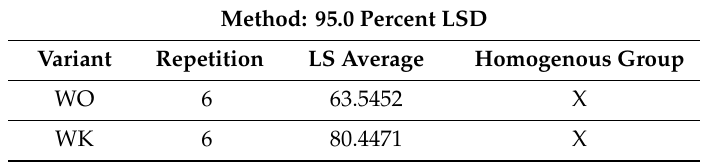
Table 10. Influence of the year on the total content of 19 monitored phenolic substances in wine in 2015 and 2016 for the RIE